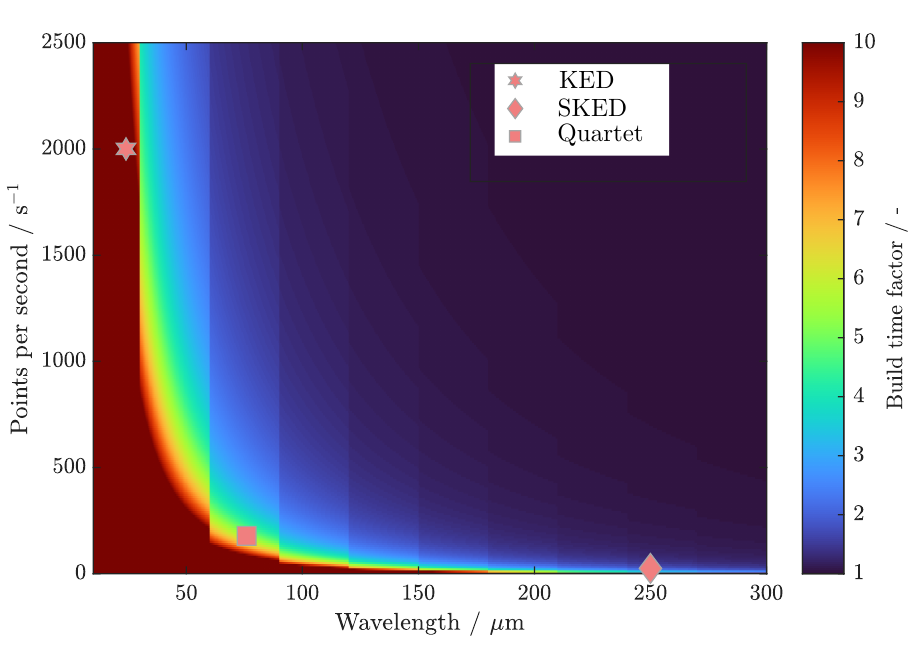
Figure 13. Ratio of build + scan time to build time, as a function of inspection wavelength and data points captured per second. Marked points show the parameter for three of the detectors, where KED is single-shot and high-resolution but requires smooth surfaces, and SKED was on L-PBF sample with 116 averages with 250 µ m wavelength, and Quartet was from the etched sample, using 16 averages and 80 µ m